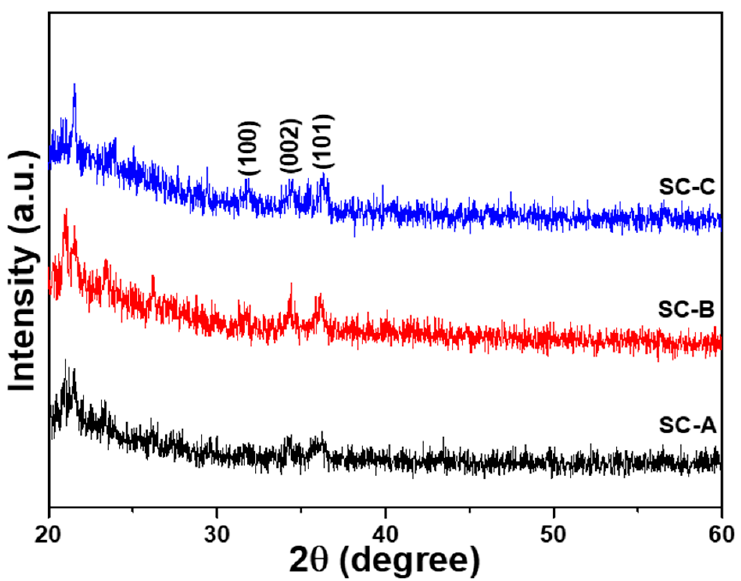
Figure 2. XRD spectra of the ZnO seed layers on substrates with different thicknesses of Al sacrificial layers. Al thicknesses for SC-A, SC-B, and SC-C were 120, 420, and 720 nm, respectively.